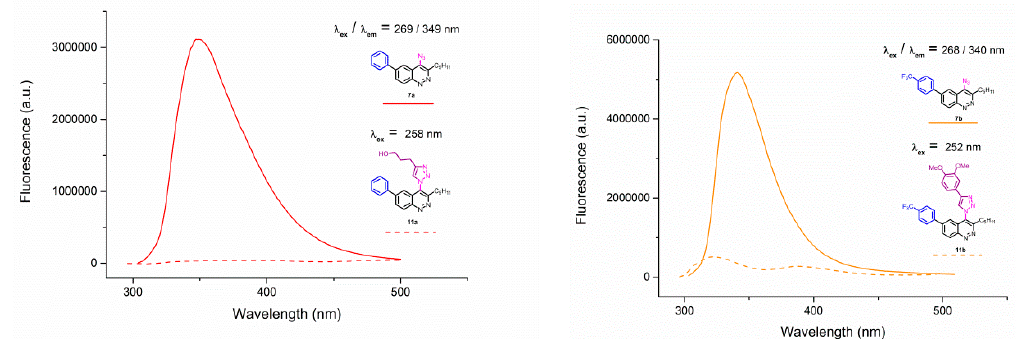
Molecules 2019 , 24 , x FOR PEER REVIEW Figure A1. Emission spectra of 4-azidocinnolines / 4-triazolylcinnolnes 7a / 11a ; 7b / 11b ; 7e / 11e ; 7f / 11f. Figure A1. Cont.